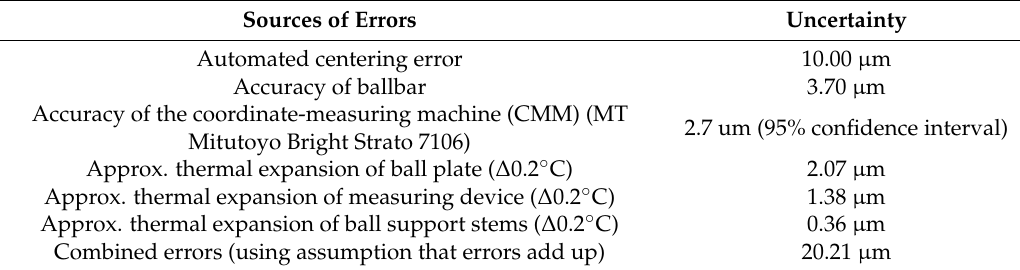
Table 2. Sources of errors related to the measuring